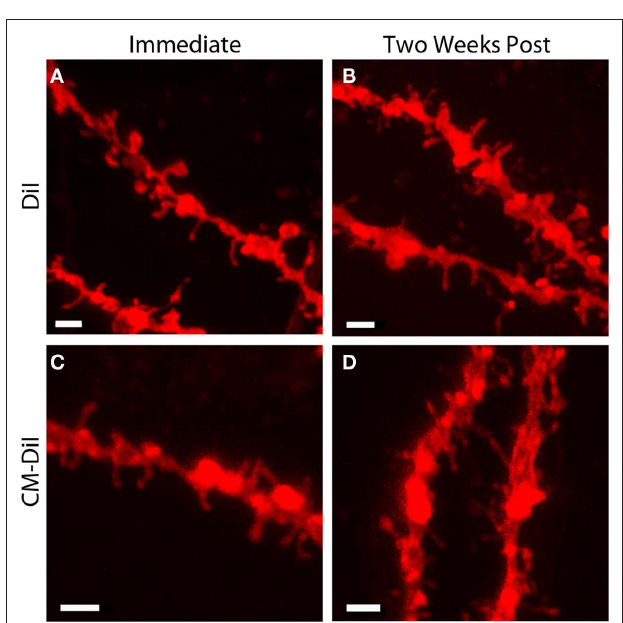
Figure 7 | images of permeabilized dendritic segments, labeled with either Dii or CM-Dii. DiI labeled dendritic segment imaged (A) immediately or (B) 2 weeks following tissue mounting. CM-DiI labeled dendritic segment imaged (C) immediately or (D) 2 weeks following tissue mounting. For both DiI (B) and CM-DiI (D) dendritic segments, qualitative degradation of image quality is apparent 2 weeks following tissue mounting. Scale bar is 2